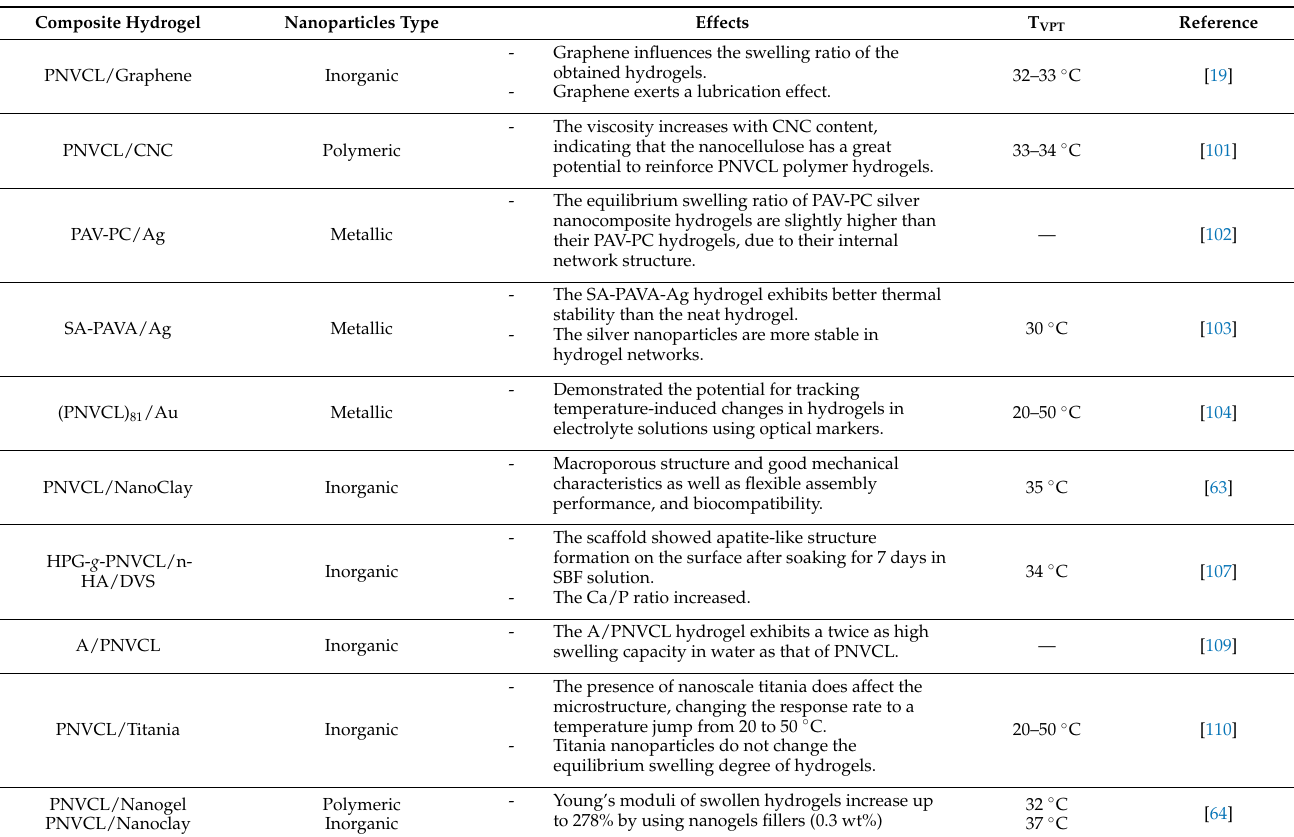
Table 2. Recent studies in the field of composite PNVCL